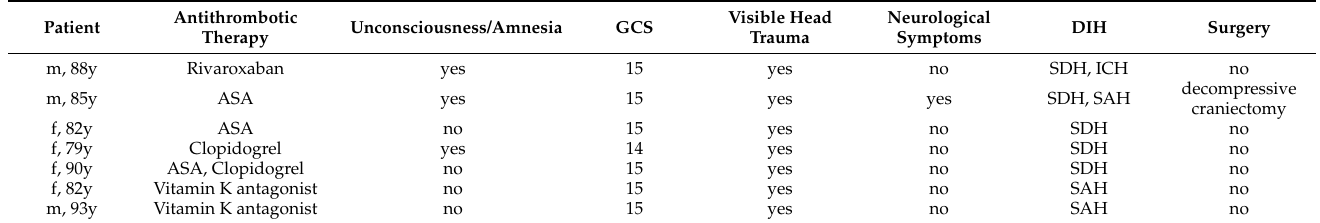
Table 3. Details of patients with delayed intracranial hemorrhage including history of unconscious- ness or amnesia at presentation, GCS at presentation, visible head trauma, such as wounds or hematoma, neurological symptoms during the in-hospital observation, and surgery due to DIH.